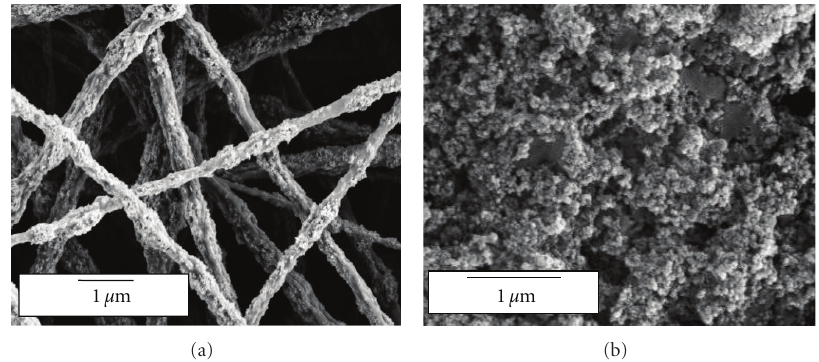
Figure 1: SEM micrographs showing morphological features of (a) electrospun and (b) cast P(3HB)-TiO 2 film.